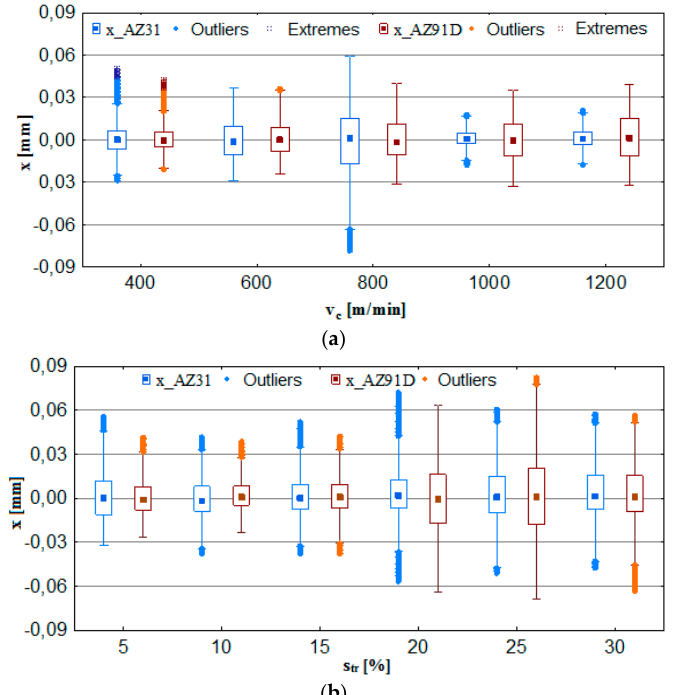
Figure 8. Effect of cutting speed and trochoidal step on vibrations displacement in milling of magnesium alloys: ( a ) v c (f z = 0.15 mm/tooth, a p = 6 mm, s tr = 15%) and ( b ) s tr (v c = 800 m/min, f z = 0.15 mm/tooth, a p = 6 mm).